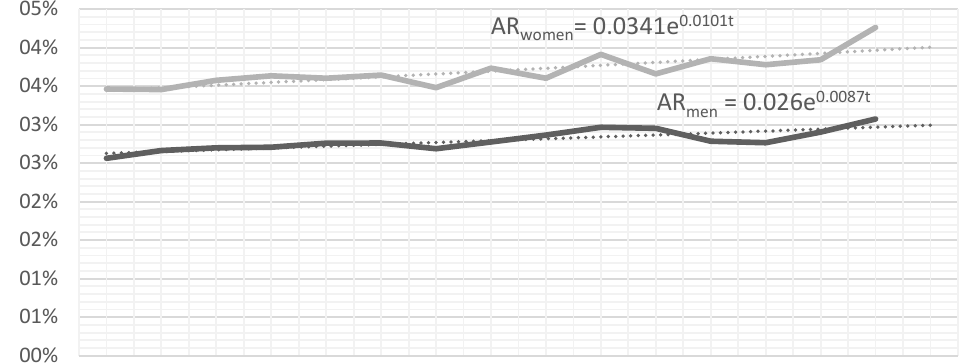
Figure 1. Dynamics of the absence rate for men and women due to own illness or disability in European countries, 2006 – 2020. Note: AR — sickness absence rate; t — time. Table 2. Statistics of the absence rate due to own illness or disability for European men and women (average, 2006 – 2020).